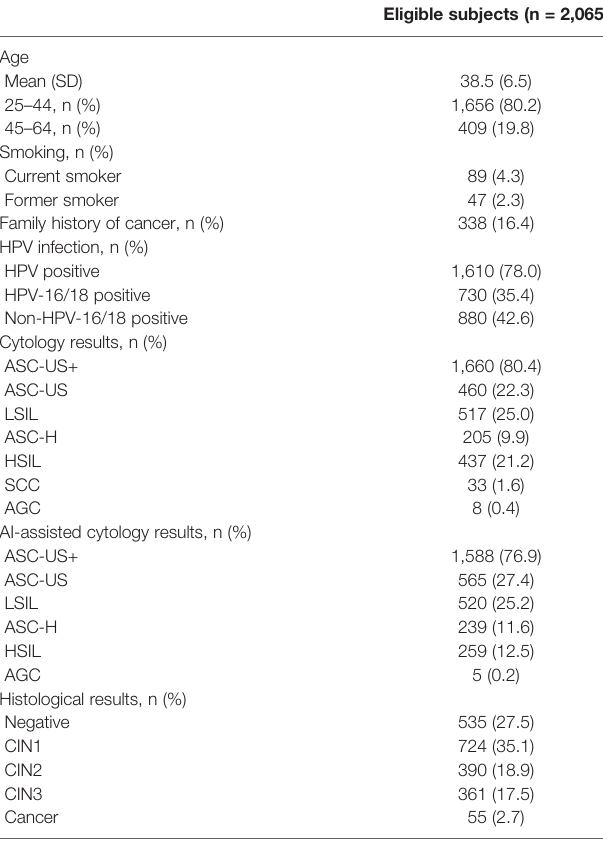
TABLE 1 | Demographic and clinical characteristics of participants in the